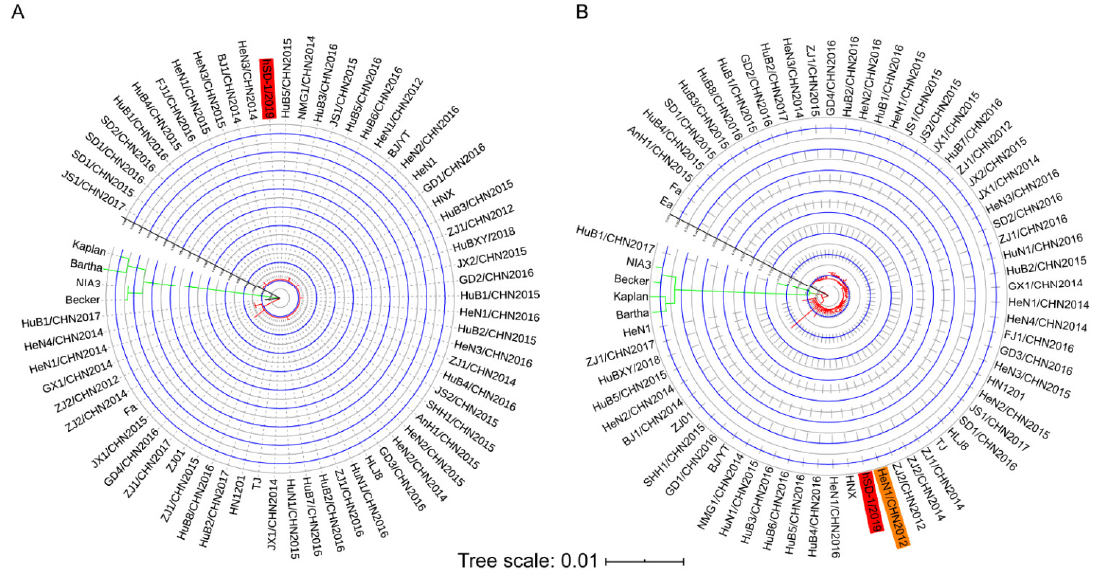
Figure 2. Phylogenetic analyses of human-originated and pig-originated PRV strains ( A ) A maximum likelihood tree was generated based on the full length of the gC coding gene. ( B ) A maximum likelihood tree was generated based on the complete genome sequences. Maximum likelihood trees were generated by using the Beast 2 program (version 2.6.3) through the Gamma correction for site heterogeneity and the GTR model. A bootstrap value of 1000 was also applied, and the tree was visualized by using the iTOL tool.